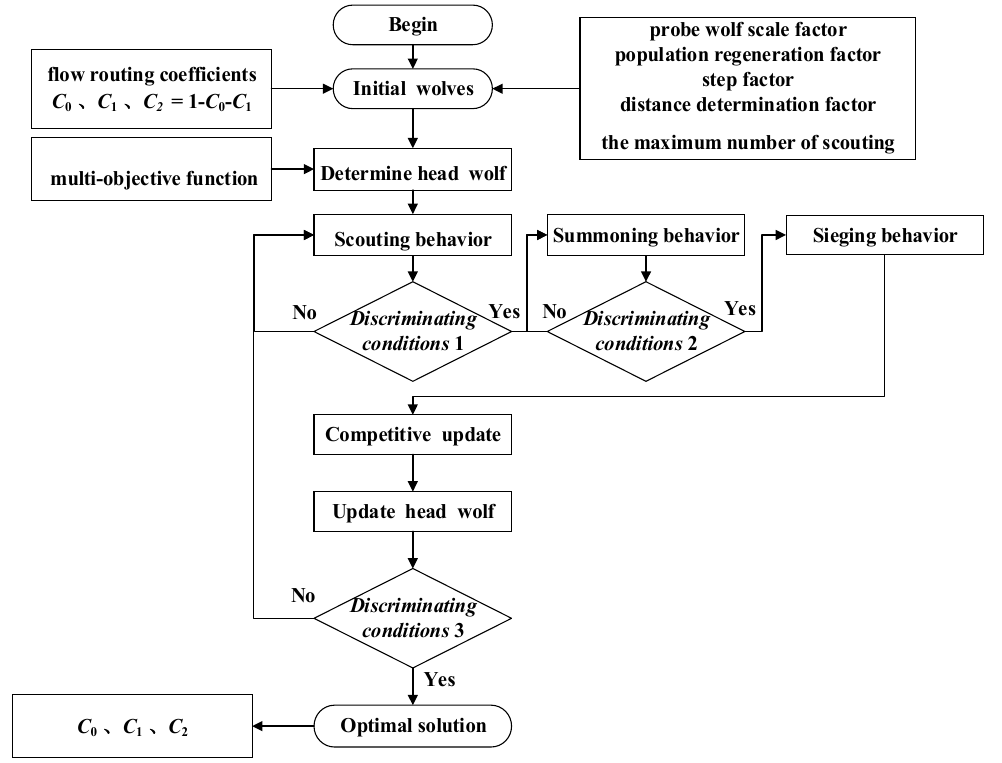
Figure 2. Flow chart of parameter estimation.